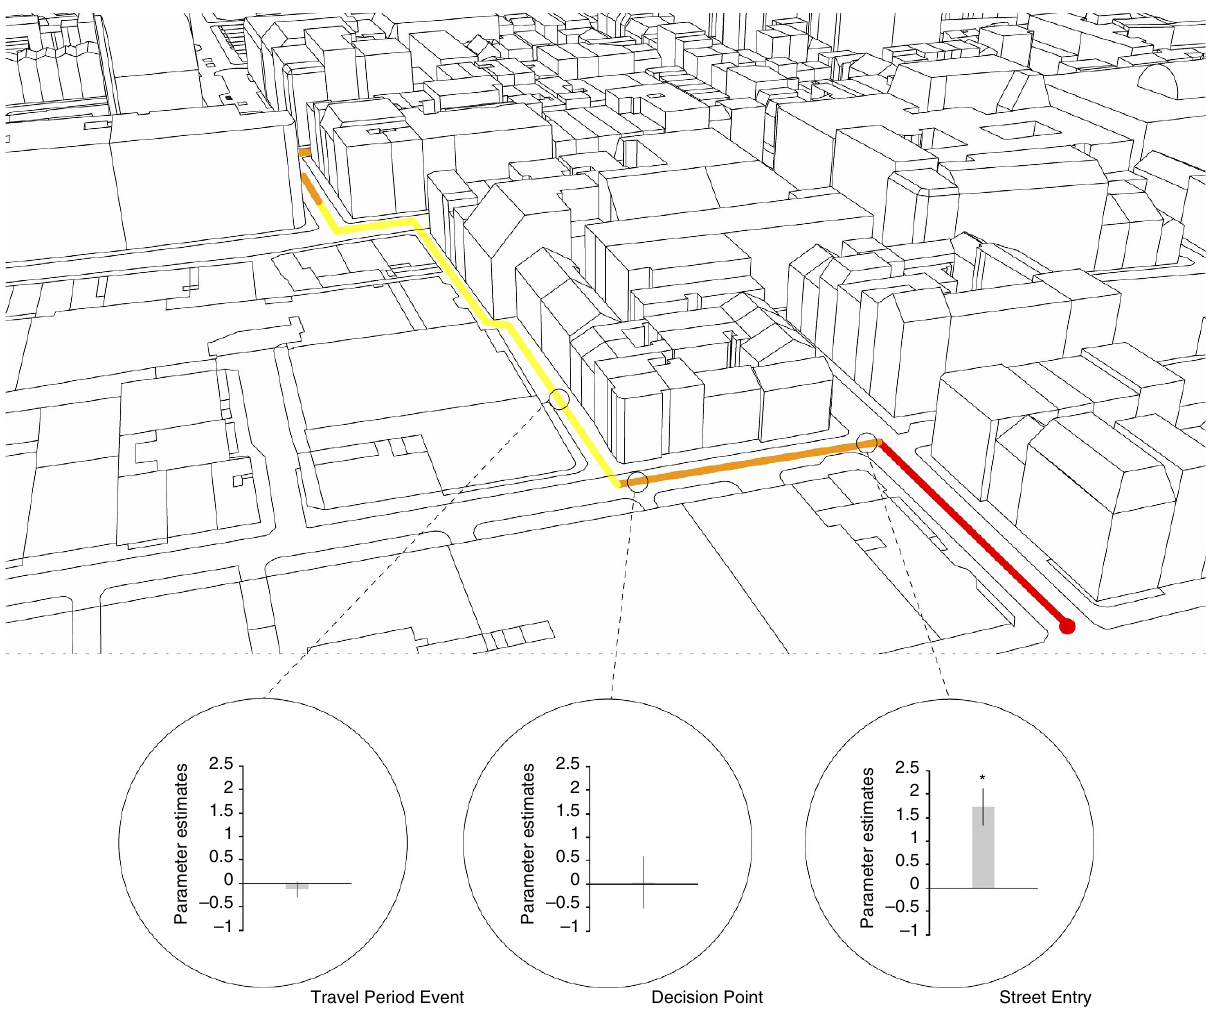
Figure 4 | Posterior hippocampal activity correlated with the change in degree centrality specifically at Street Entry Events. Top: perspective view of Soho showing part of the example route (Fig. 2a) shown to illustrate the three examples of the different time points examined. During navigation routes, right posterior hippocampal activity was significantly more correlated with the change in degree centrality at Street Entry Events than at Decision Points ( t 23 ¼ 2.34, P ¼ 0.02) or at Travel Period Events ( t 23 ¼ 4.01, P ¼ 0.001), *Significance at a threshold of P o 0.05 corrected for ROI. Error bars denote